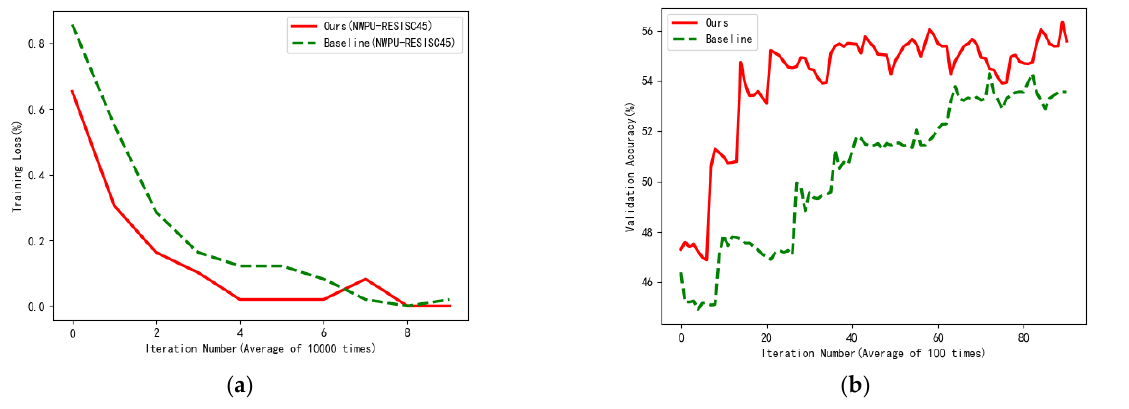
Figure 6. Comparison of training loss and validation accuracy for 5 ‐ way 1 ‐ shot scenarios on the NWPU ‐ RESISC45 dataset. ( a ) shows the training loss, and ( b ) shows the validation accuracy.